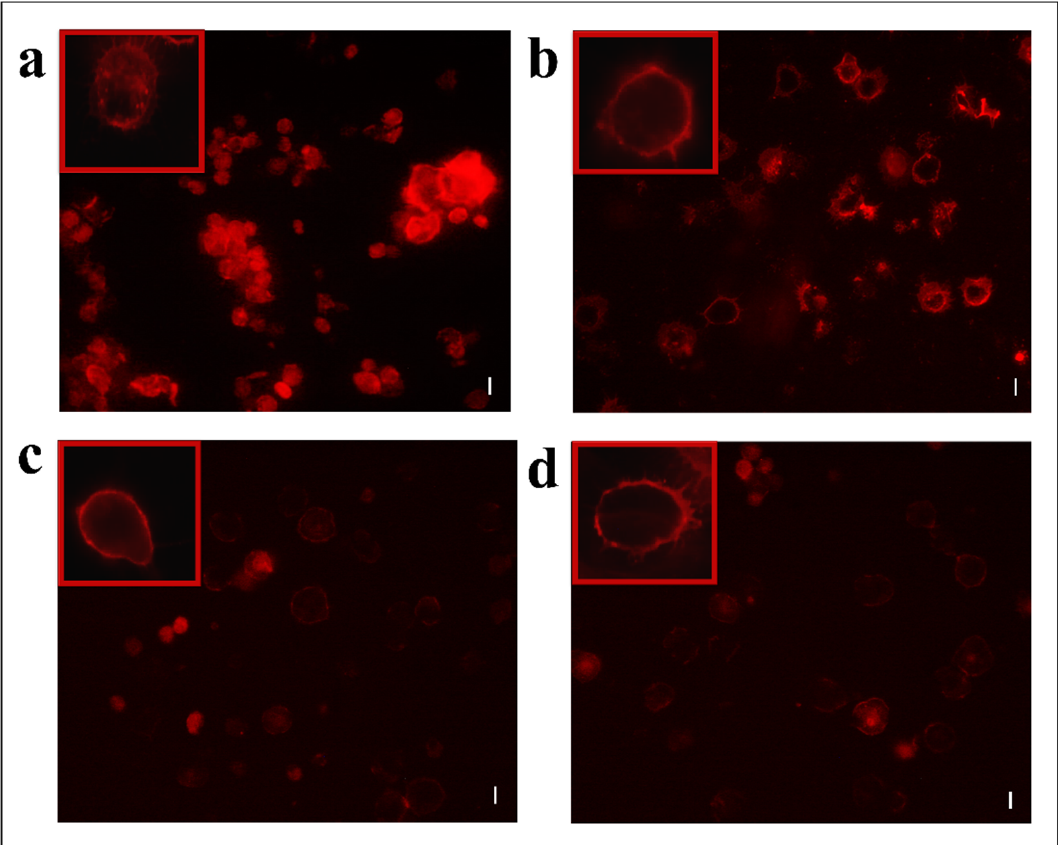
Figure 5. TRITC-conjugated phalloidin staining of hemocytes treated with 1 X PBS (control) ( a ) or treated with OPs deriving from two equivalent females, ( b ) fraction #22 ( c ) and fraction #26 ( d ). Scale bar 10 µm. In red boxes, enlarged cells are reported.